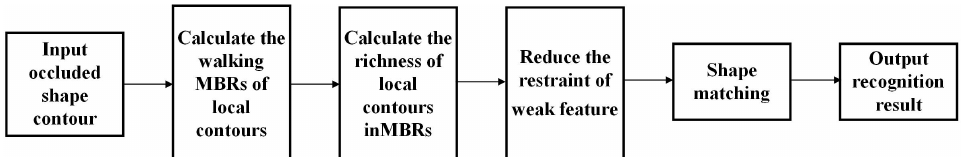
Figure 2. The structural framework of the proposed method is divided into seven parts, from the input of the occluded shape to the final output of shape recognition results using